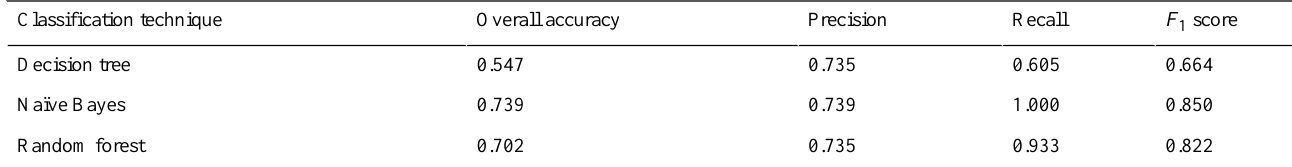
Table 7. Classification performance for rate of change of the Repeatable Battery for the Assessment of Neuropsychological Status score when applied to the evaluation data set (training set size=740; evaluation set